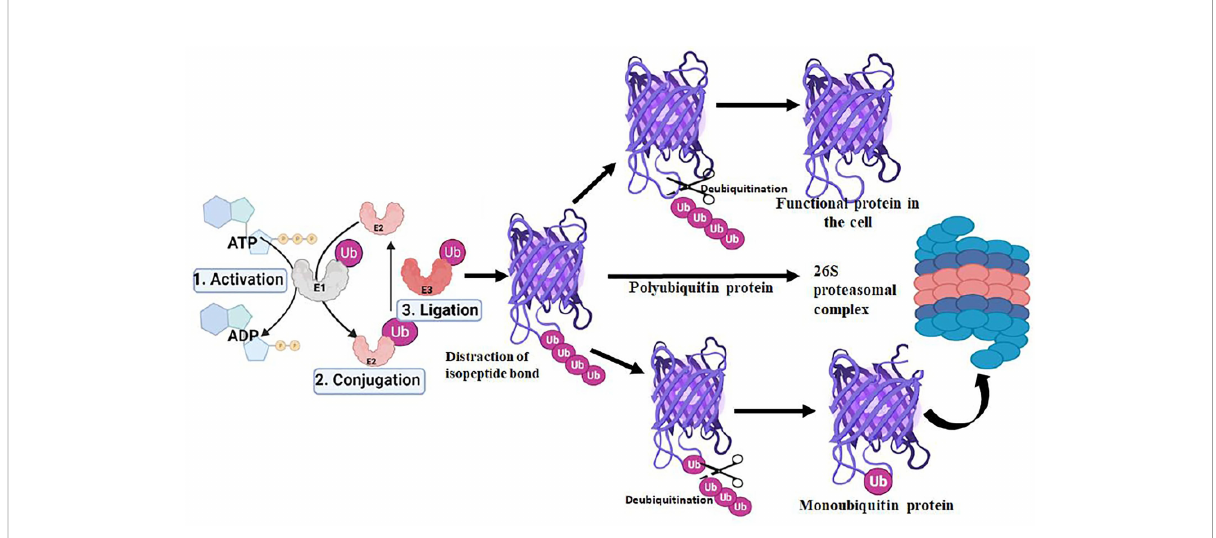
FIGURE 2 Role of deubiquitination in proteasomal degradation pathway of protein in the proteasome